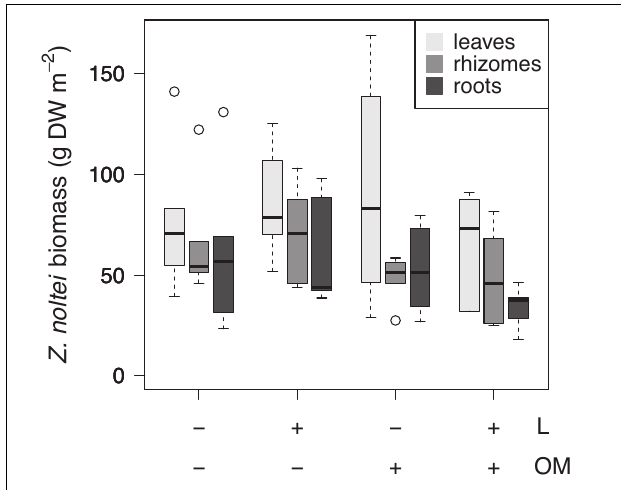
FIGURE 4 | Boxplots of Z. noltei biomass per tissue (leaves, rhizomes, roots) per treatment (n = 6 per treatment). L, addition of Loripes orbiculatus clams; OM, addition of organic matter; DW, dry weight. Midline in box; median; box: 25th and 75th percentiles; whiskers: 1.5 × interquartile range; circles: